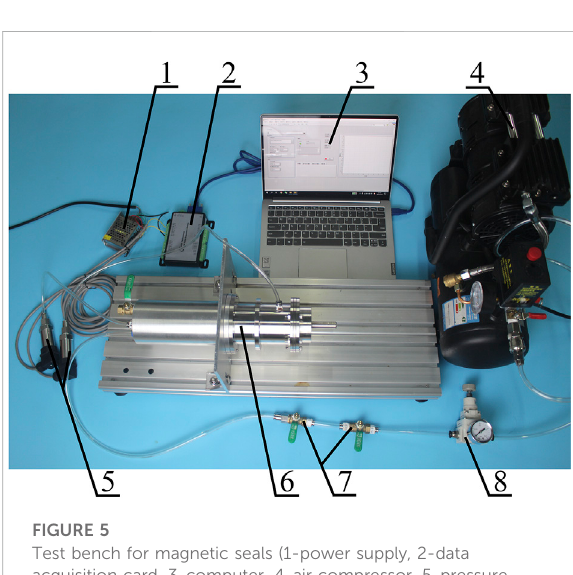
FIGURE 5 Test bench for magnetic seals (1-power supply,